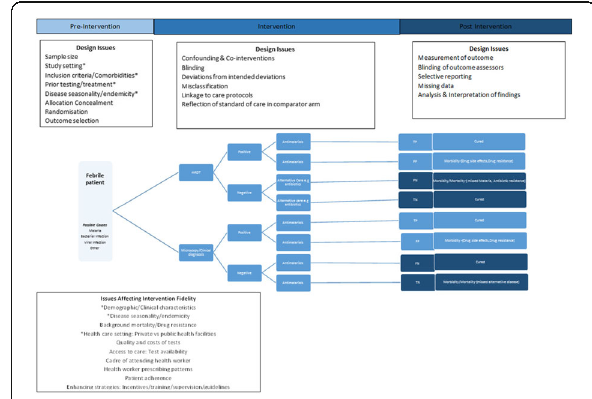
Fig. 1 (abstract P43). Design & Fidelity Considerations when measuring impact of malaria RDTs on Morbidity/Mortality compared to clinical or microscopy